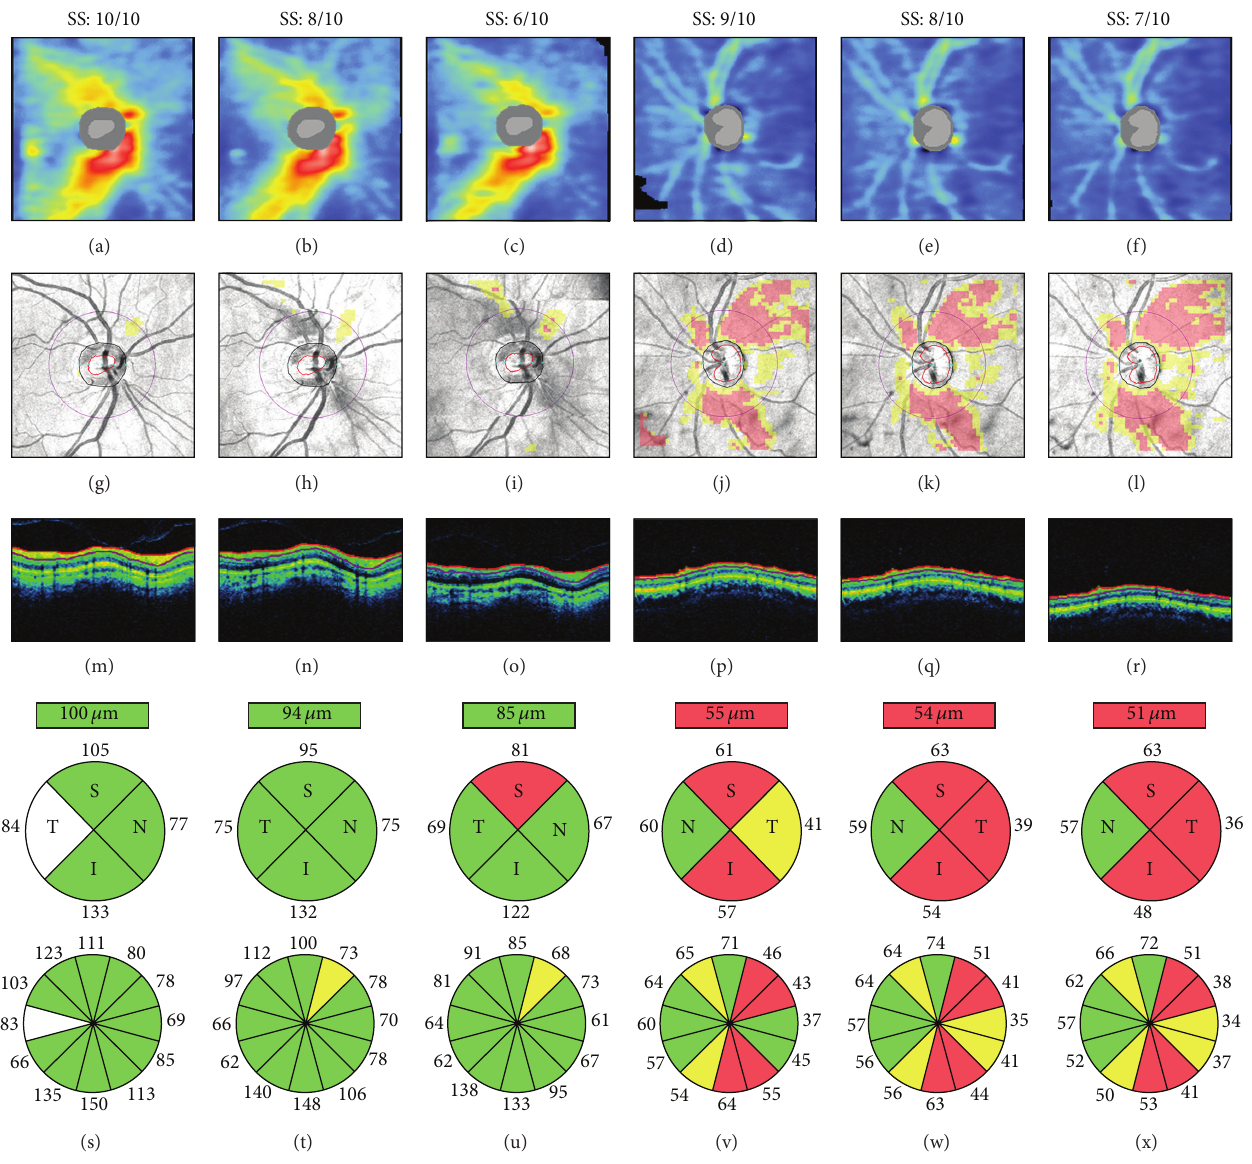
Figure 6: Signal strength and retinal nerve fiber layer (RNFL) thickness. Cirrus HD-OCT RNFL thickness maps ((a)–(f)), RNFL deviation maps ((g)–(l)), circular tomograms ((m)–(r)), and printout results ((s)–(x)) from two eyes. All scans had signal strength ≥ 6, the cut-off for acceptable image quality. Both cases show progressive signal attenuation ((m)–(o) and (p)–(r)), RNFL thinning and classification changes ((s)–(u) and (v)–(x)), and worsening of the RNFL thickness maps and RNFL deviation maps as signal strength decreases. Left: scans collected within a 2-week interval and sorted by decreasing signal strength; note the superotemporal reduction of the warmed-colored areas on the RNFL thickness maps, indicating RNFL thinning ((a)–(c)), and the corresponding clusters of “superpixels” on the RNFL deviation maps ((g)–(i)). Right: scans collected consecutively on the same day; note the progressive inferotemporal expansion of the “superpixels” cluster on the RNFL deviation maps ((j)–(l)). SS: signal